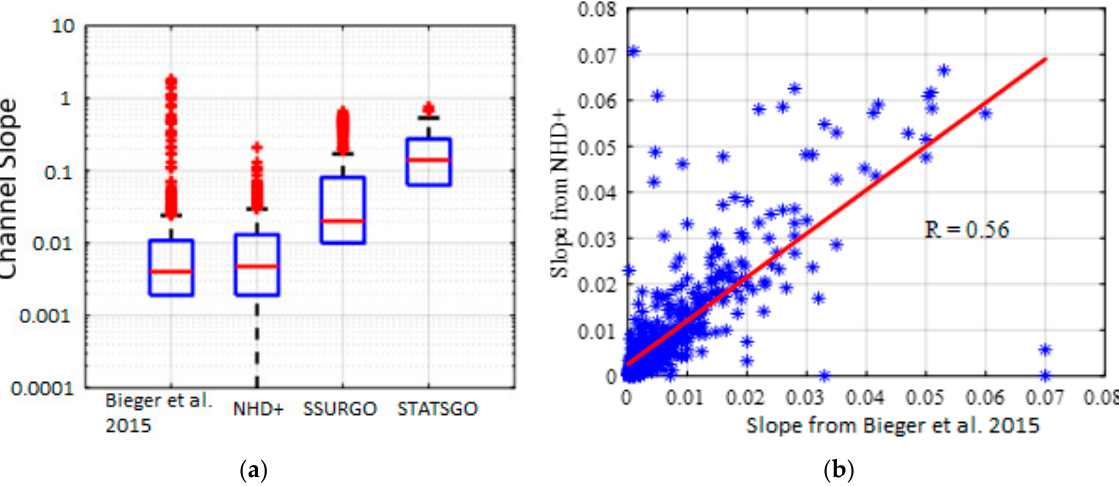
Figure 3. Comparison of slope ( a ) between the four sources (red dots indicate outliers and blue boxes are range of data with 25th and 75th percentiles), and ( b ) between NHD+ and Bieger et al. [33].